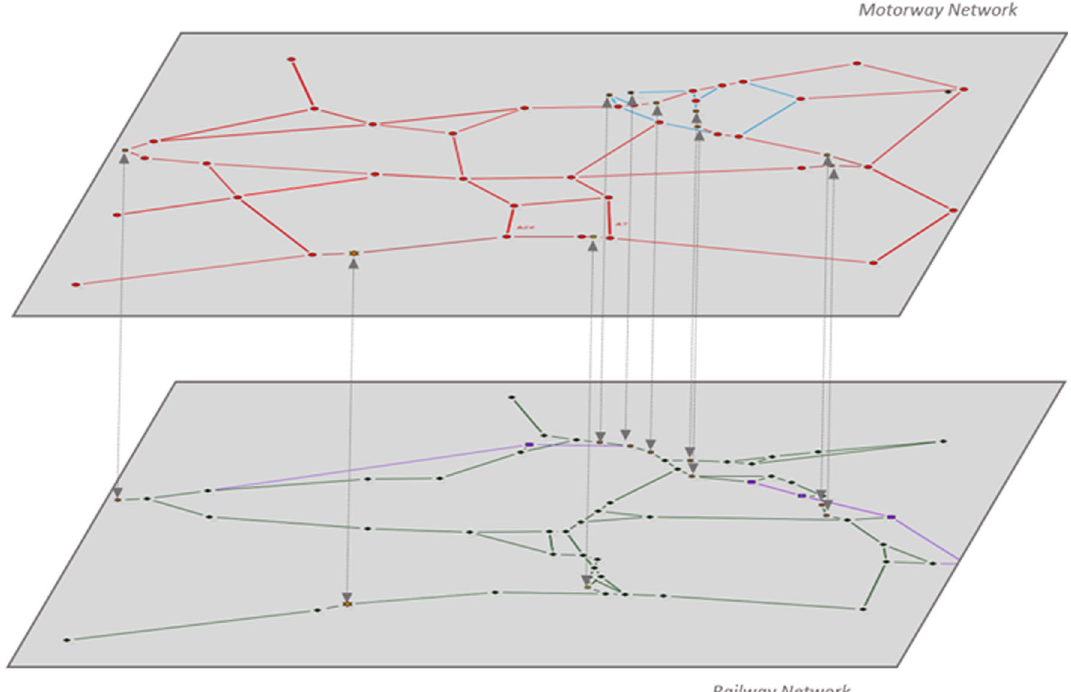
Fig. 2 Multi-layer Network—overpass points. Source : Authors’ own